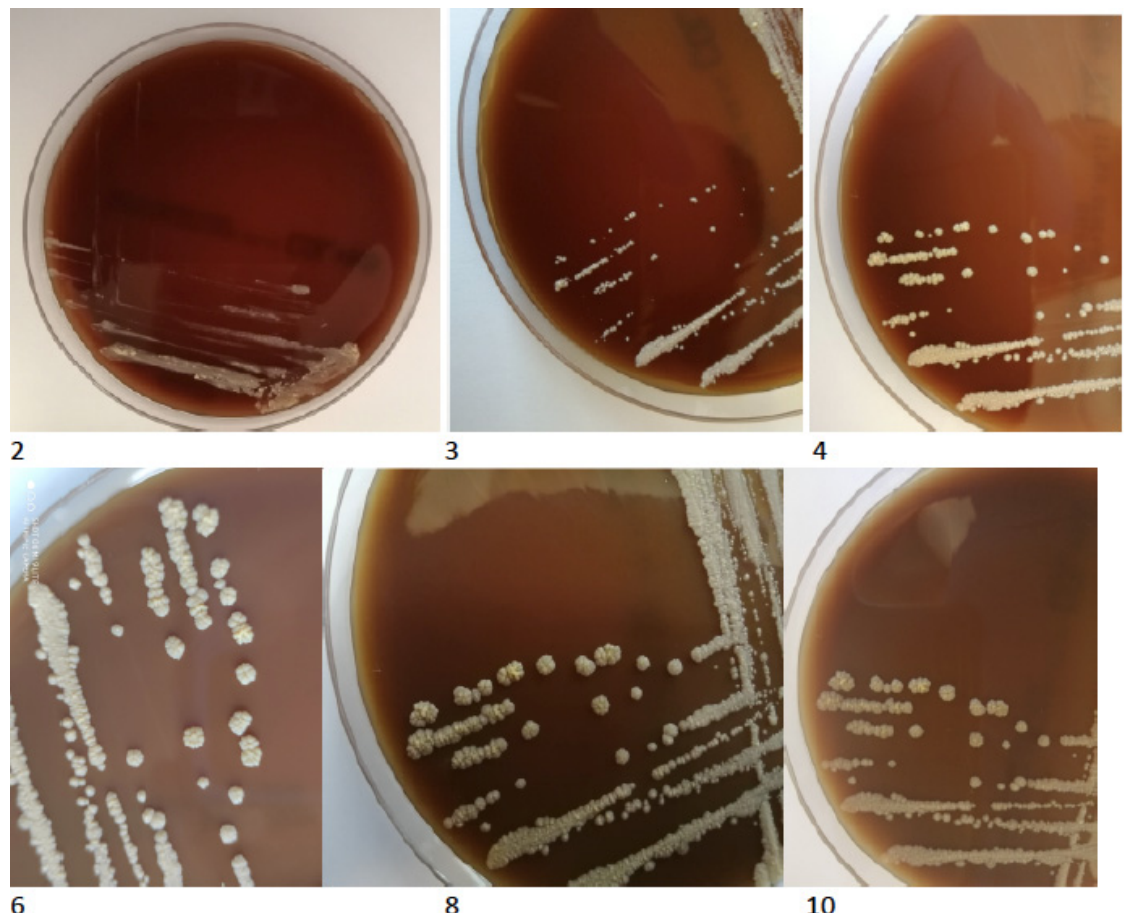
Figure 4. The growth of tiny creamy-yellowish colonies observed on Columbia blood agar plates (2, 3, 4, 6, 8, 10 days of incubation).